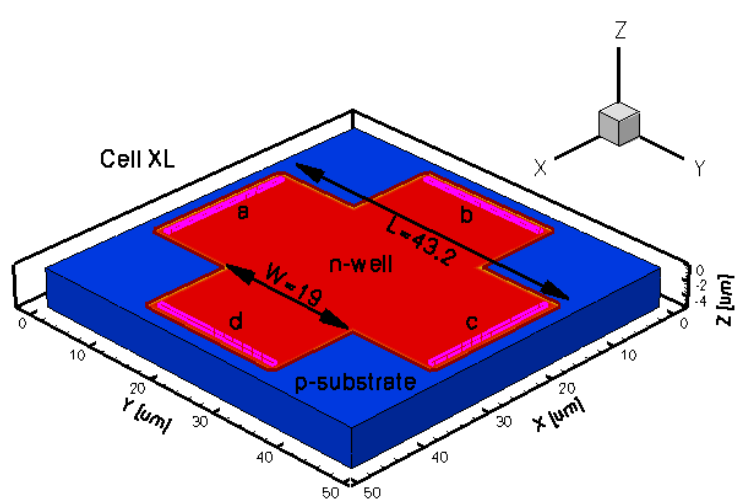
Figure 4. 3D representation of the XL simulated Hall cell.